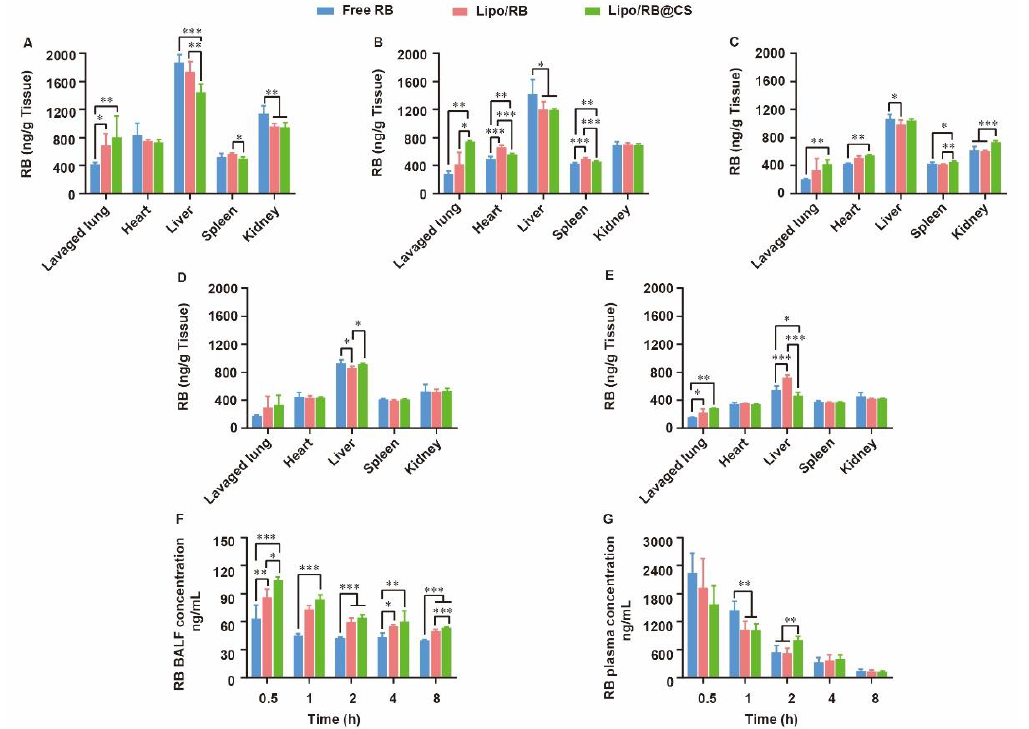
Figure 5. Biodistribution of RB in mice at ( A ) 0.5 h, ( B ) 1 h, ( C ) 2 h, ( D ) 4 h and ( E ) 8 h after inhalation of RB formulations and the concentration of RB in ( F ) BALF and ( G ) plasma. All the data were expressed as mean + SD ( n = 6). * p < 0.05, ** p < 0.01, *** p < 0.001.